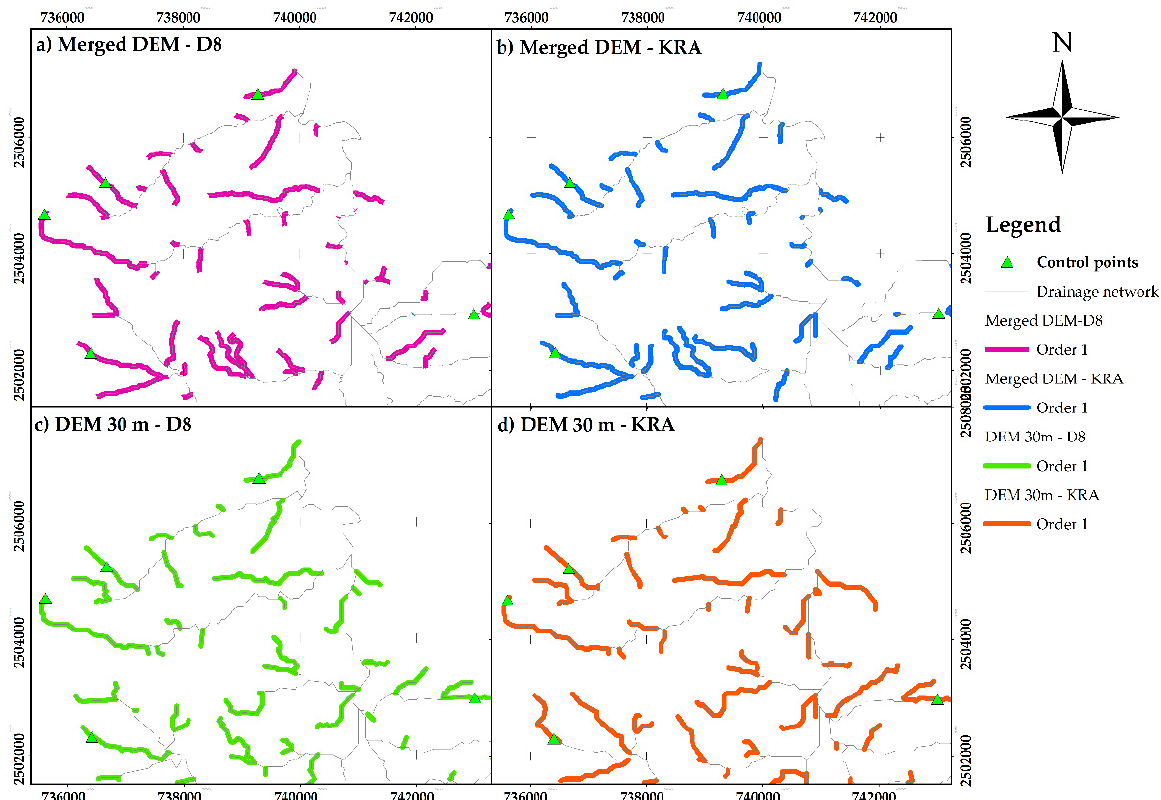
Figure 7. Drainage networks, control points, and channels of stream order 1.